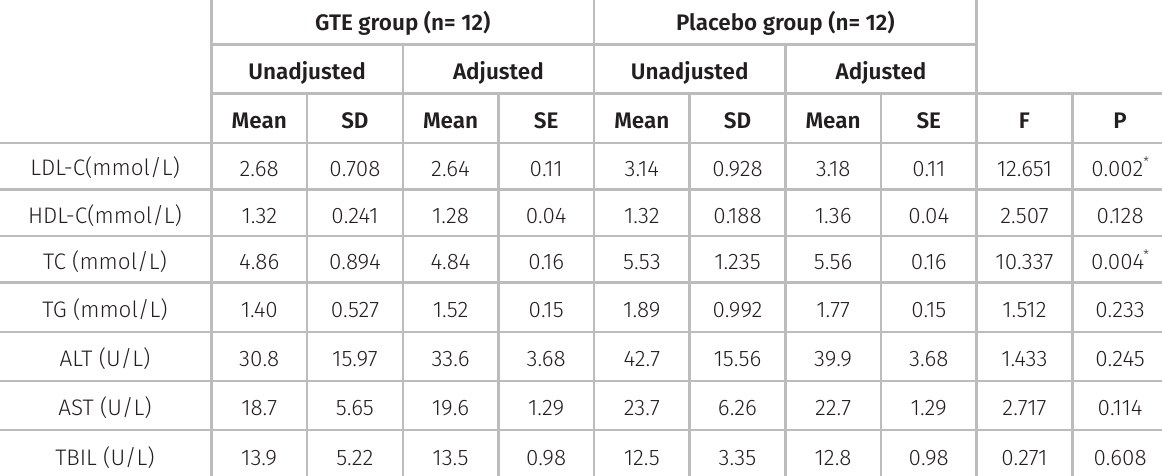
Table II. Blood lipid profiles and liver function in ANCOVA after 12